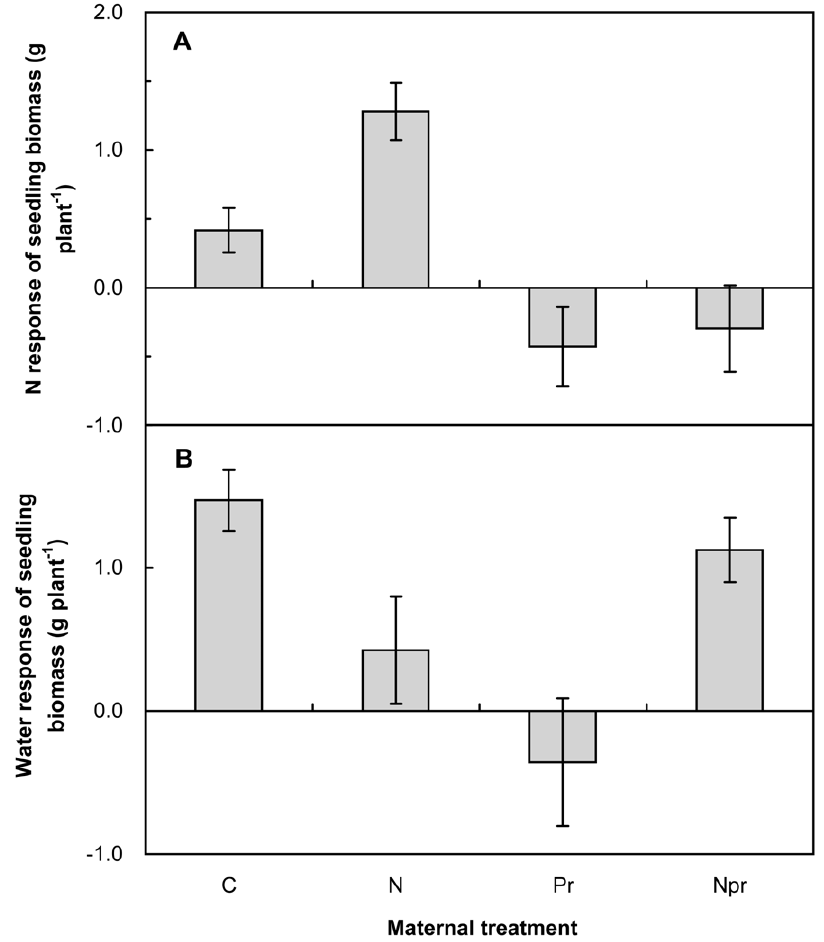
Figure 6. Effects of maternal-treatments on the N (a) and water (b) responses of seedling biomass. Data are mean 6 SE (n=7). See Figure 1 for abbreviations. The seedlings were germinated by the seeds collected from the 4 maternal treatment plots (control, N addition, increased precipitation, and N addition plus increased precipitation) in the field and grown under the 4 offspring treatments (control, N addition, increased precipitation, and N addition plus increased precipitation) in the greenhouse. The N responses were calculated as the absolute difference (g plant 2 1 ) in seedling biomass between with and without offspring N-addition. The water responses were calculated as the absolute difference in seedling biomass between the offspring ambient- and increased-precipitation.